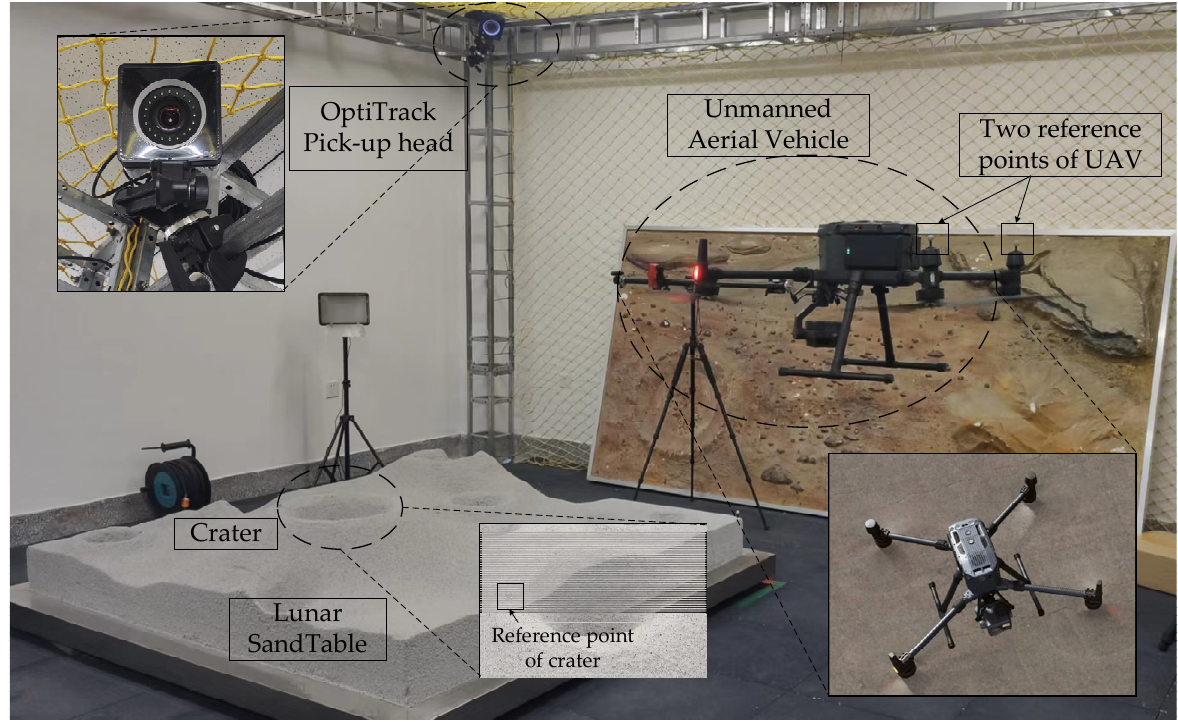
Figure 13. Hardware-in-the-loop simulation test environment.